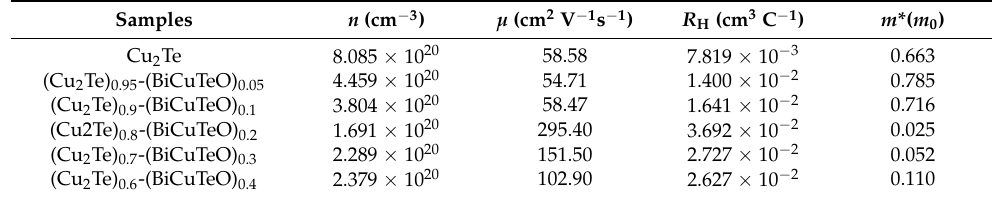
Table 1. Carrier concentration and mobility of (Cu 2 Te) 1 − x -(BiCuTeO) x. ( R H is Hall